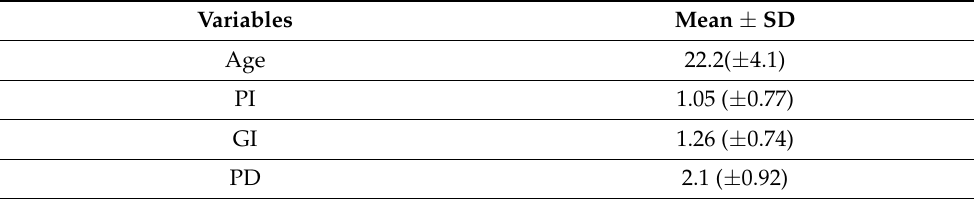
Table 1. Subjects’ characteristics.